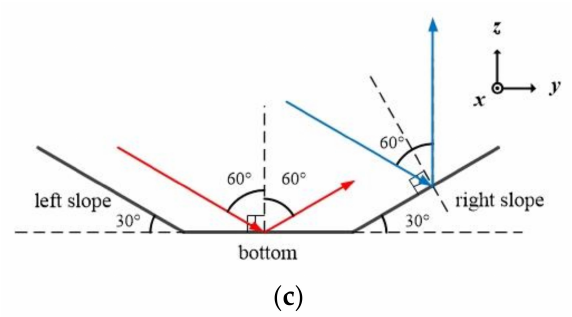
Figure 22. Illustration of EM wave propagation paths in canyon/valley: ( a ) θ i = − 30 ◦ ; ( b ) θ i = − 45 ◦ ; ( c ) α i = − 60 ◦